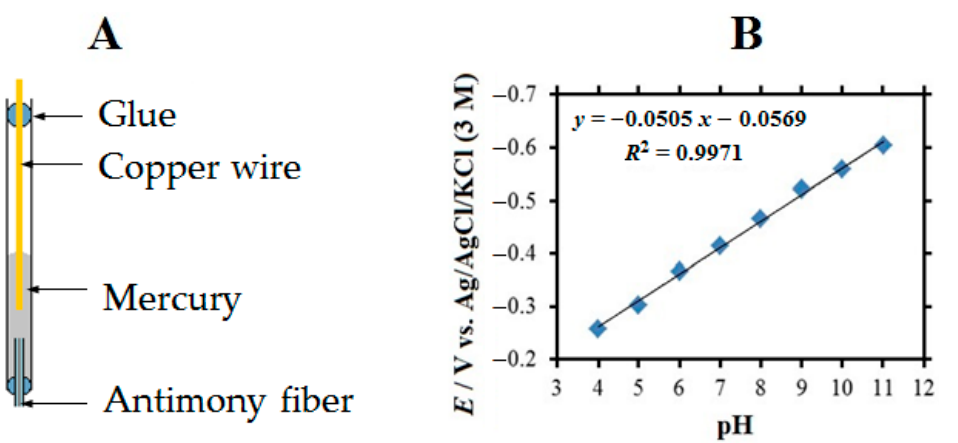
Figure 2. ( A ) Schematic and ( B ) calibration curve of a pH-sensitive single-barrel antimony microe-